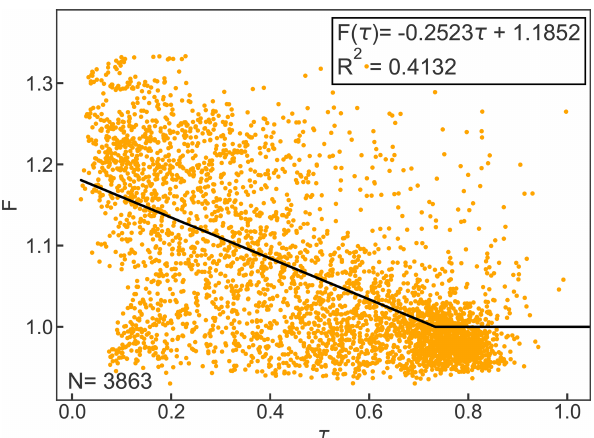
Figure B1. Cloud factor F as a function of atmospheric emissivity τ for hourly observations. The black line represents the linear equation for F(τ) and F ≥ 1. Clear-sky emissivity is parameterized based on Konzelmann et al. (1994).